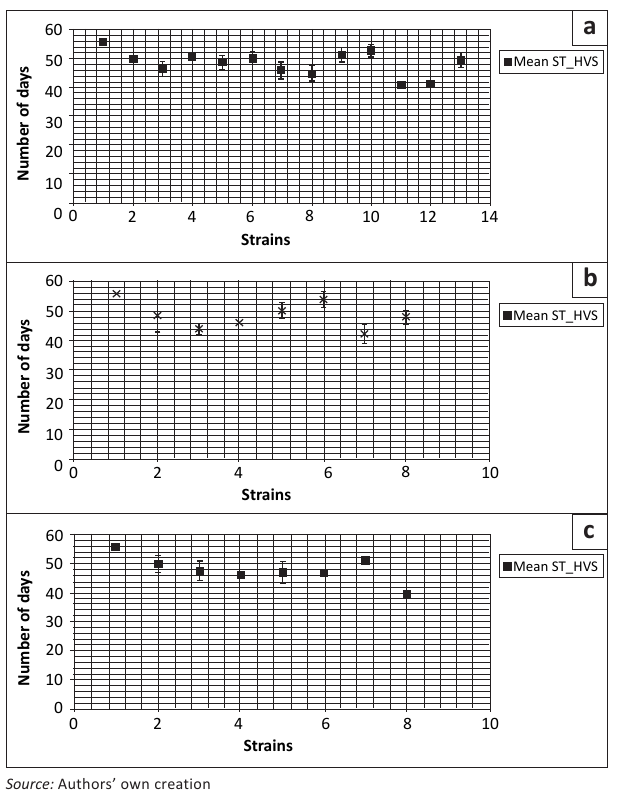
FIGURE 4: Significance in the pre-patent period, patent period, survival time and packed cell volume between strains collected from Hluhluwe-iMfolozi Park, cattle near (< 5 km) and far (> 10 km) from game parks, with least significant difference calculated at p =